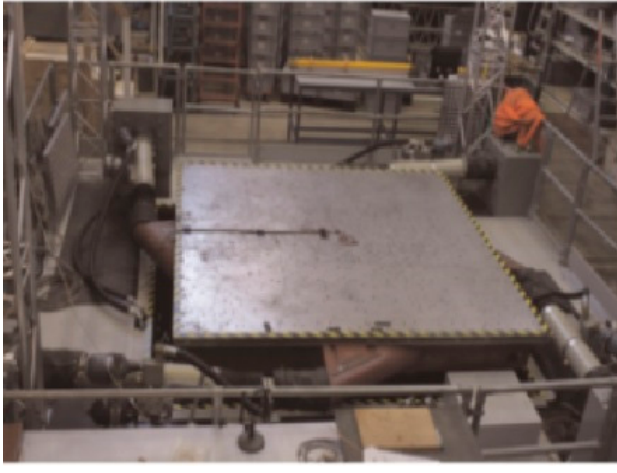
Figure 1. The hydraulic shaking table. Table 1. The detail parameters of the shaking table.